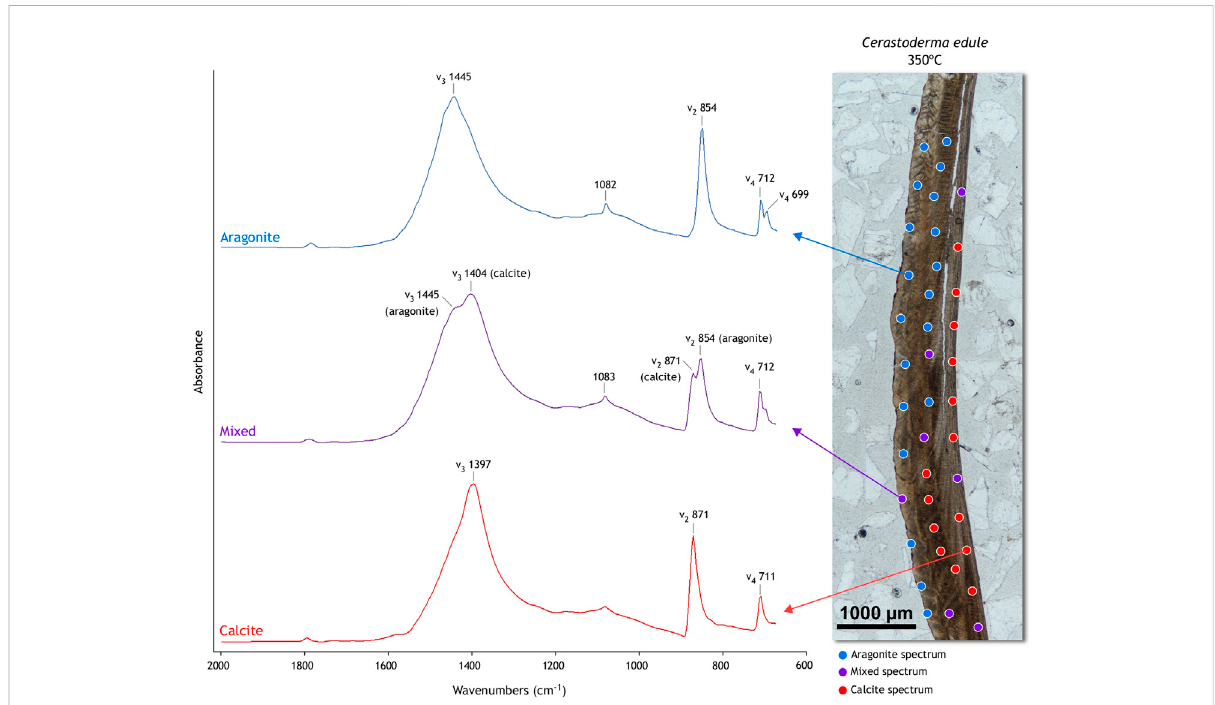
FIGURE 4 (A) Examples of microFTIR spectra of aragonite, calcite, and mixing both, obtained in experimentally heated specimen of Cerastoderma edule . (B) Petrographic microphotograph of the analyzed specimen with an example of the regular distribution of points to obtain microFTIR measurements; note the distribution of calcite spectra along the inner surface and aragonite spectra in the outer surface, showing a heterogenous